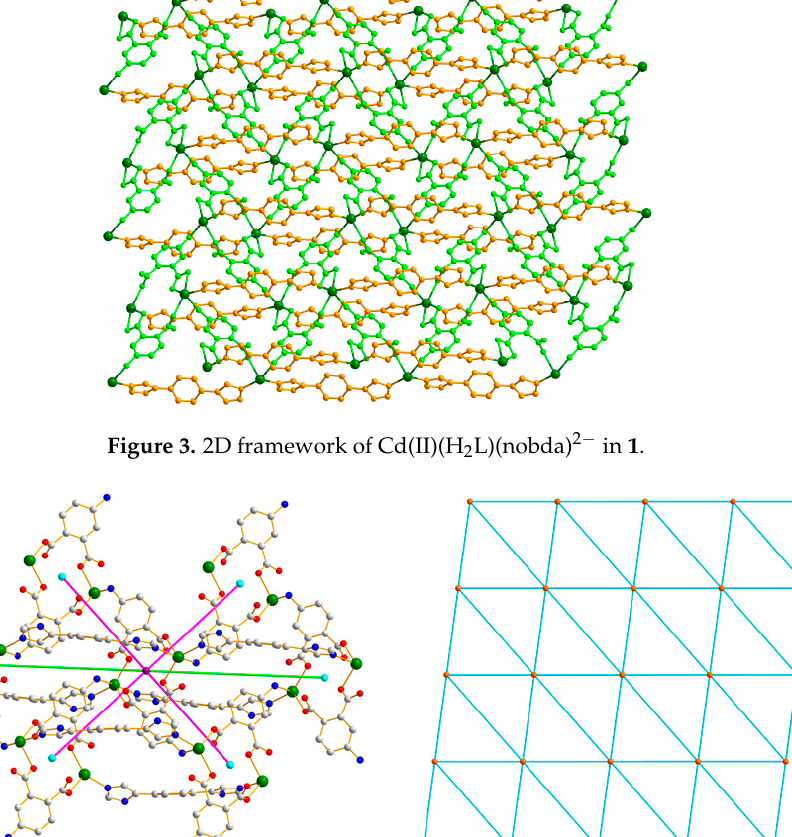
Figure 4. The 6-connected node based on the binuclear unit in 1 linked by the nobda 2 − and H 2 L ligands ( left ); A view of the uninodal 6-connected net with the Schläfli symbol (3 3 · 4 10 · 5 · 6) in complex 1 based on Cd 2 (COO) 2 binuclear motifs ( right ).